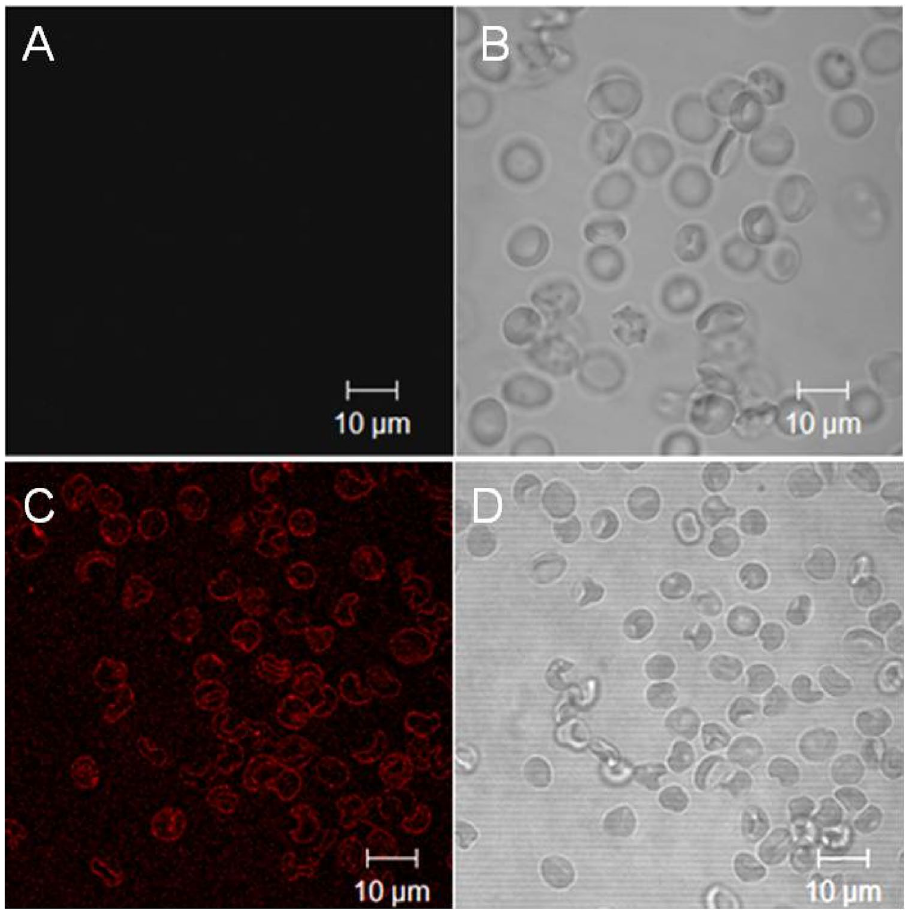
Figure 5. Phospholipids asymmetry and phospholipids packing in RBC membrane analyzed by merocyanine 540 (MC540) binding. Control biconcave-discoid RBC ( A and B ) and stomatocytic RBC ( C , D ) induced by compound 8 at 0.1 mg/mL. The confocal images (right panel) show fluorescence (in C ) due to the binding of MC540 to the RBC membrane with disordered lipid packing. The left panel shows the RBC shape in the contrast phase (B-discocytes, D-stomatocytes). Presented RBC (control and compound 8 -treated) were incubated with MC540 at the same conditions. The images show representative data for three independent experiments. Scale bars indicate 10 µm.